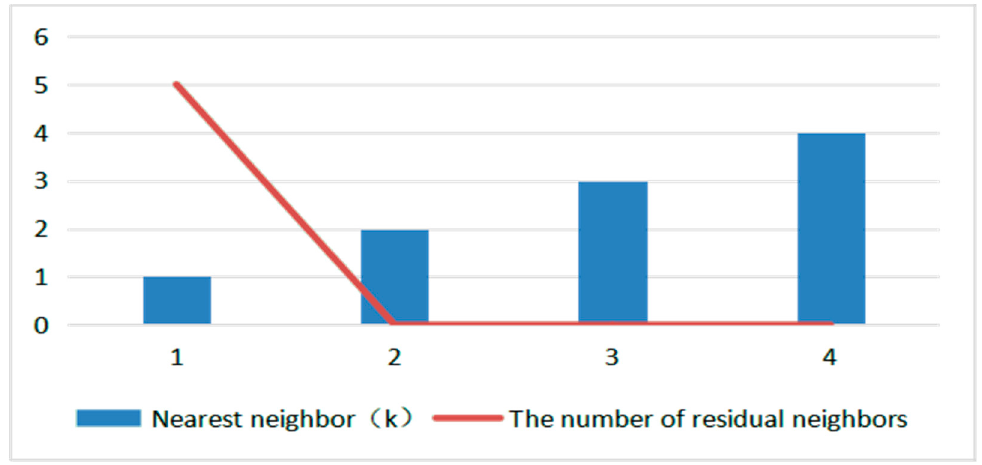
Figure 9. With the gradual increase of k, the changes of the residual neighbors of the data points.